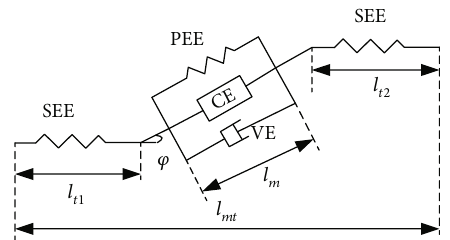
Figure 1: The improved Hill musculotendon